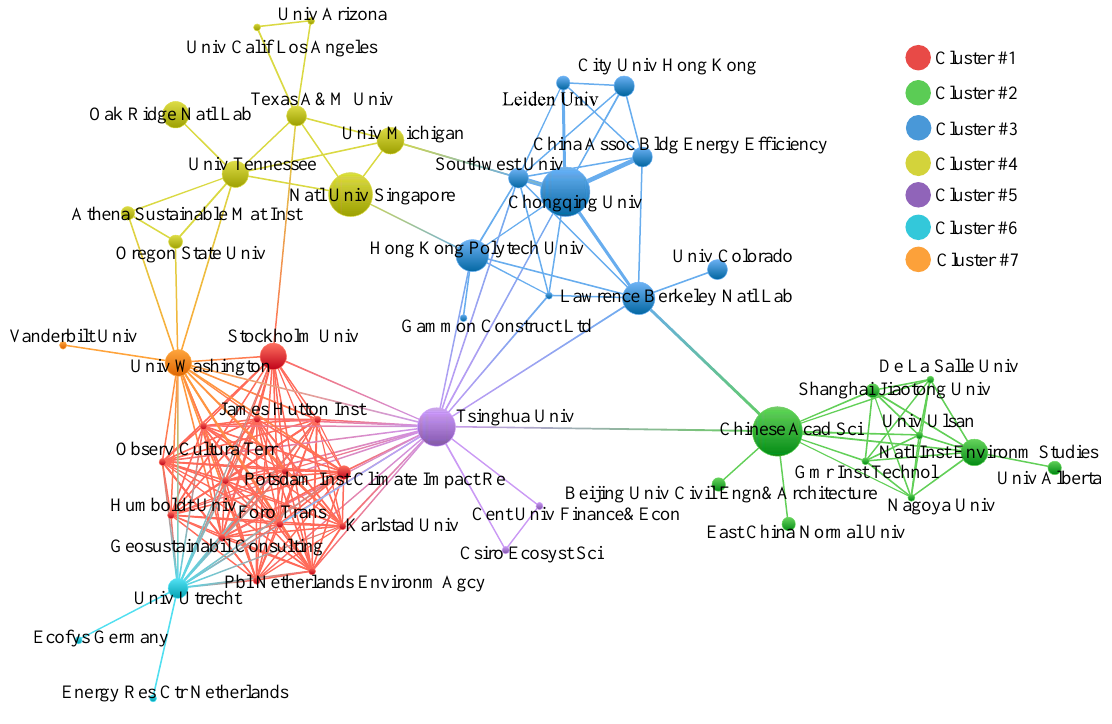
Figure 3. Knowledge domain map of institutional contributions and collaboration.